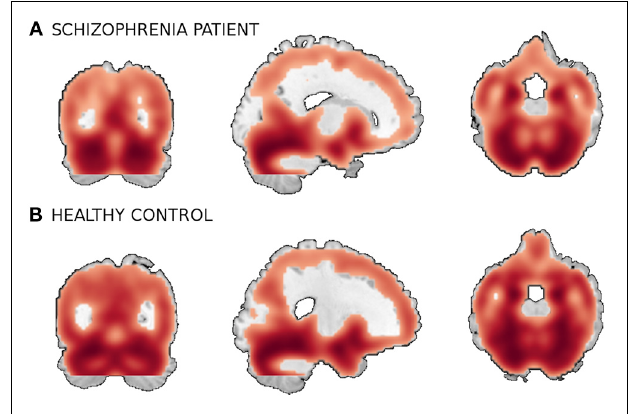
FIGURE 5 | A smoothed gray matter segmentation of a training sample of (A) a patient and (B) a healthy control.